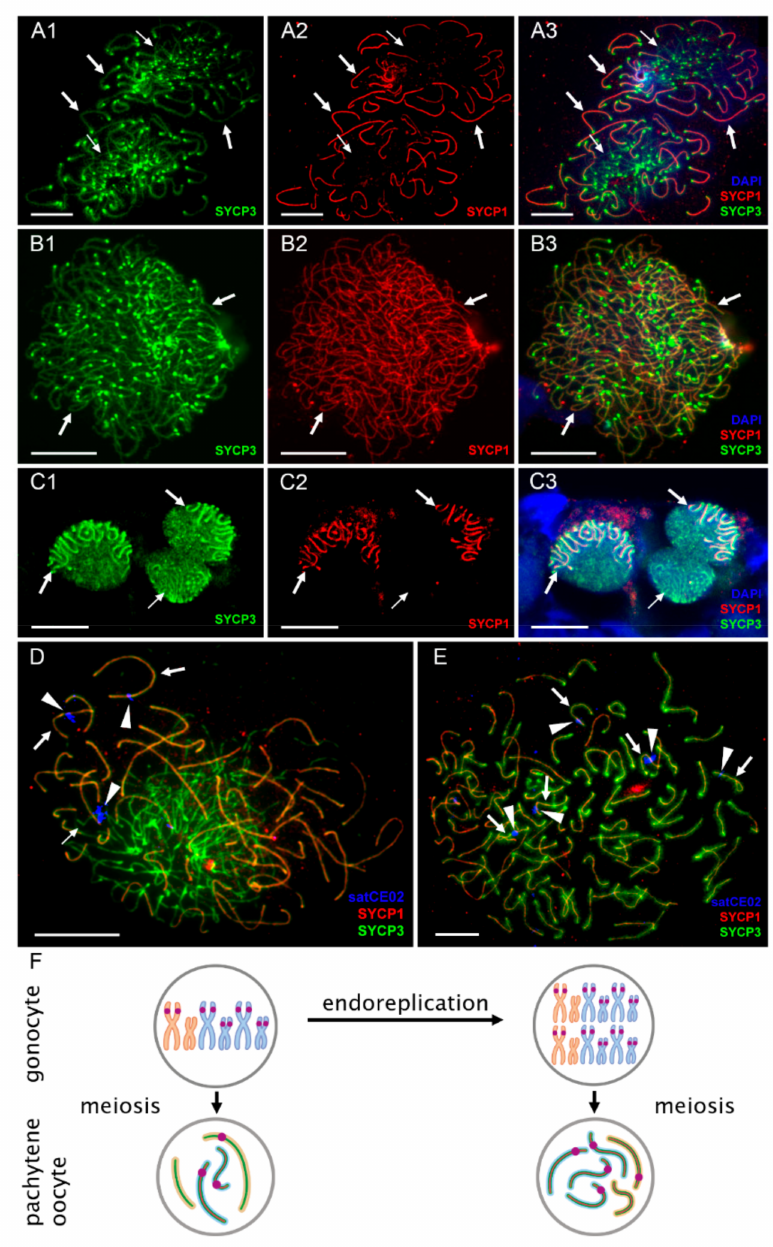
Figure 4. The analysis of pairing and ploidy level in two populations of pachytene oocytes from ovaries of triploid ETT females. Visualization of synaptonemal complexes using immunolabeling with antibodies against its lateral component (SYCP3 protein, green) ( A1 , B1 , C1 ) and central (SYCP1 protein, red) ( A2 , B2 , C2 ) components on pachytene chromosomal spreads ( A1 – B3 ) and whole tissues ( C1 – C3 ). Corresponding merged figures presented in ( A3 ), ( B3 ), ( C3 ) also include DAPI staining (blue). Bivalents accumulate both SYCP3 and SYCP1 proteins (indicated by thick arrows in panels ( A1 – B3 )); univalents accumulate only SYCP3 protein (indicated by thin arrows in panels ( A1 – B3 )). Triploid pachytene oocyte with both bivalents and univalents ( A1 – A3 ) and hexaploid pachytene oocyte with 73 bivalents ( B1 – B3 ) are presented. Images ( C1 – C3 ) are single confocal sections of 0.6 µ m in thickness. Similarly to pachytene spreads, whole mount tissue sections ( C1 – C3 ) show pachytene oocytes with bivalents only (indicated by thick arrow) and cell with both bivalents and univalent (indicated by thin arrow). Mapping of species polymorphic marker (satCE02, blue) (shown by arrowheads) on triploid ( D ) as well as hexaploid pachytene oocytes ( E ). In triploid cell (( D ),